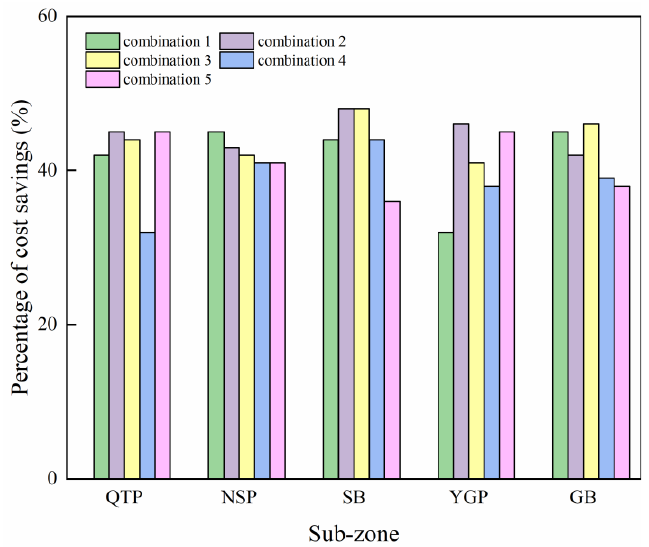
Figure 9. Percentage of computational cost saving for GA-ELM models under different input com- binations.